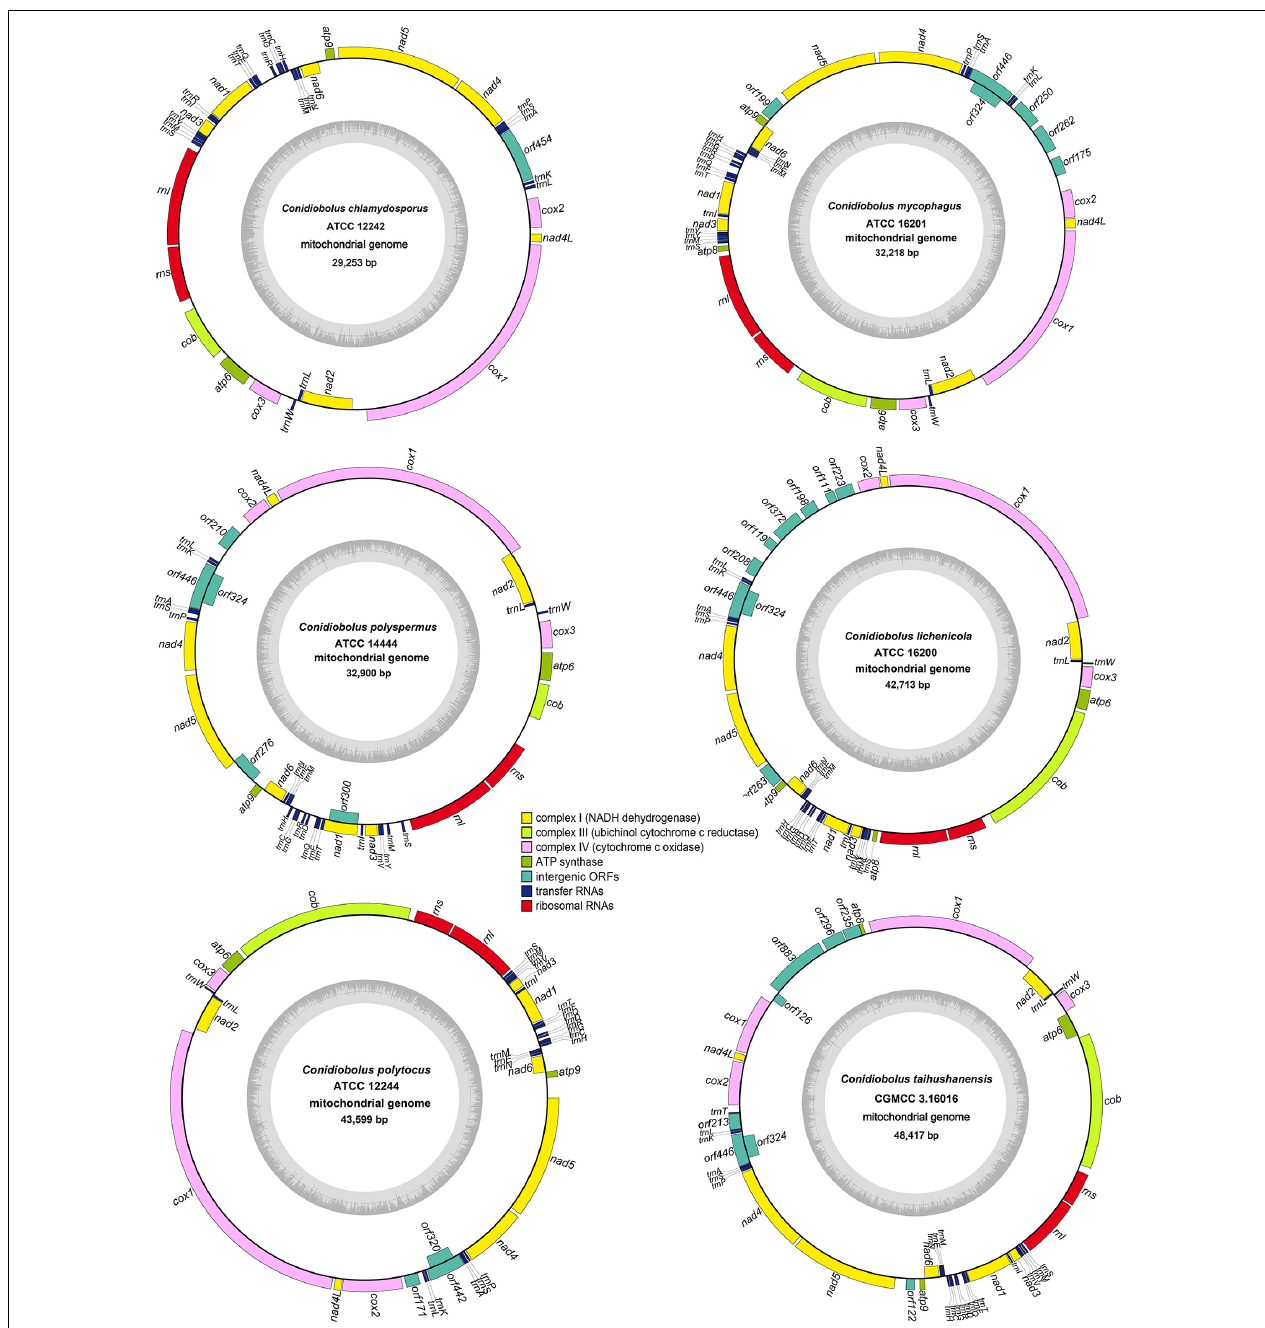
FIGURE 1 | Circular complete mitogenome maps of six ex-types in Conidiobolus s.s. genes are represented by different colored blocks. Genes outside and inside the outermost black ring line are transcribed in a clockwise and counter-clockwise direction, respectively. Inner gray rings show GC